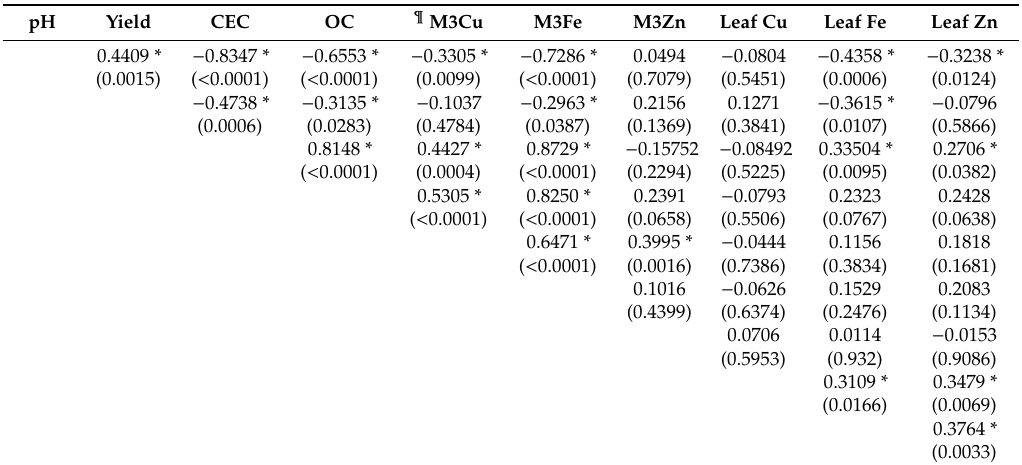
Table 3. Pearson’s correlation matrix of heavy metals concentrations, crop yields and soil properties.